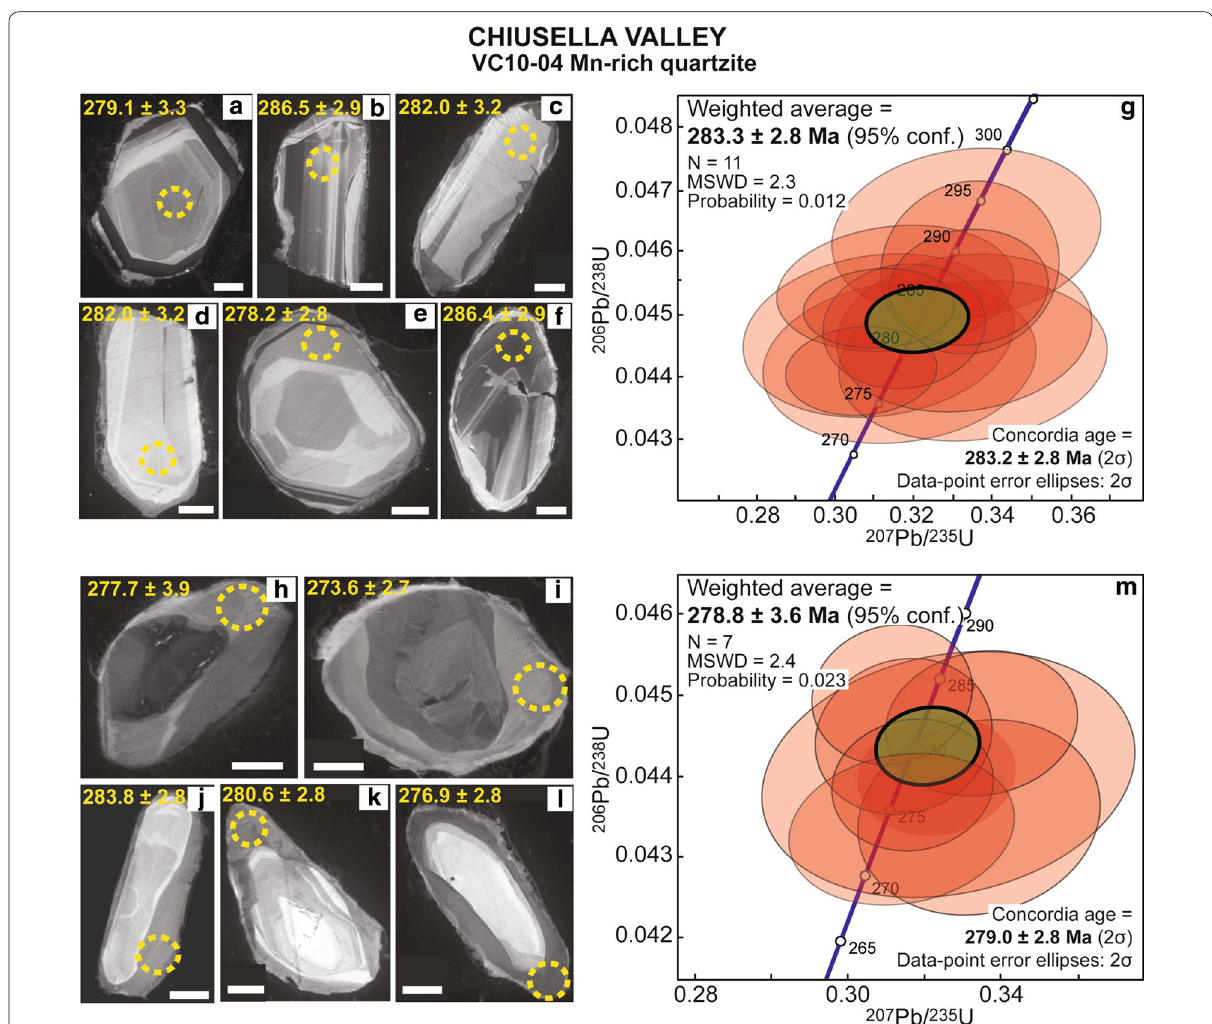
Fig. 9 Zircon in Mn-rich quartzite VC10-04 from Chiusella Valley. a – f Selected CC images of analysed zircon cores. Scale bar in all images is 30 μm. Measured spots are shown (yellow circles) with the associated date ( 1σ Ma). g Concordia plot of zircon core dates and weighted average ± 206 Pb/ 238 U age. h – l Selected CC images of analysed zircon rim1. Scale bar in all images is 30 μm. Measured spots are shown (yellow circles) with the associated date ( 1σ Ma). m Concordia plot of zircon rim1 dates and weighted average 206 Pb/ 238 U ±